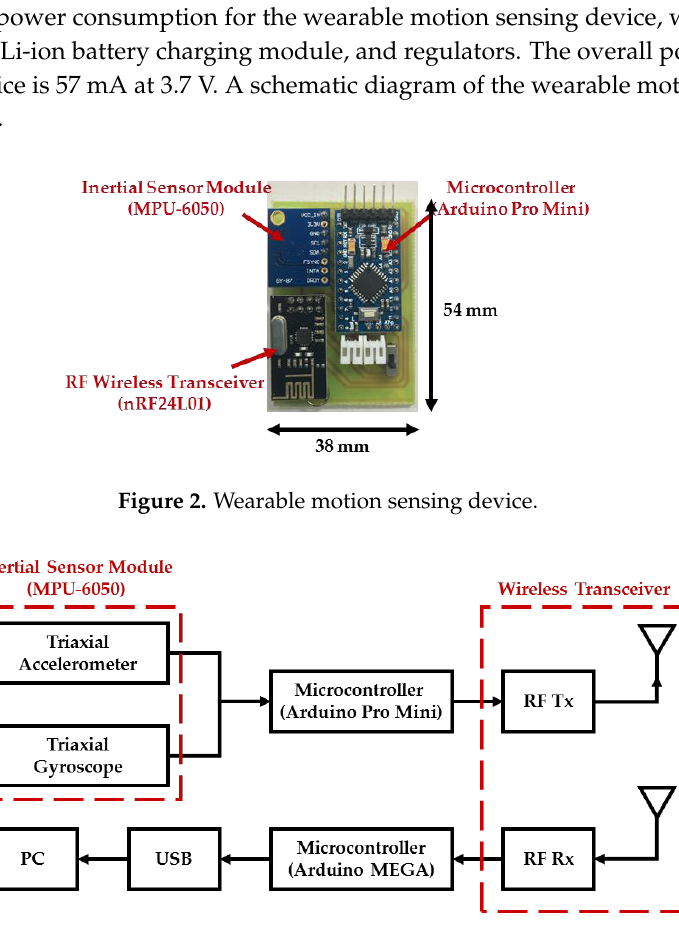
Figure 3. Schematic diagram of the wearable motion sensing device.